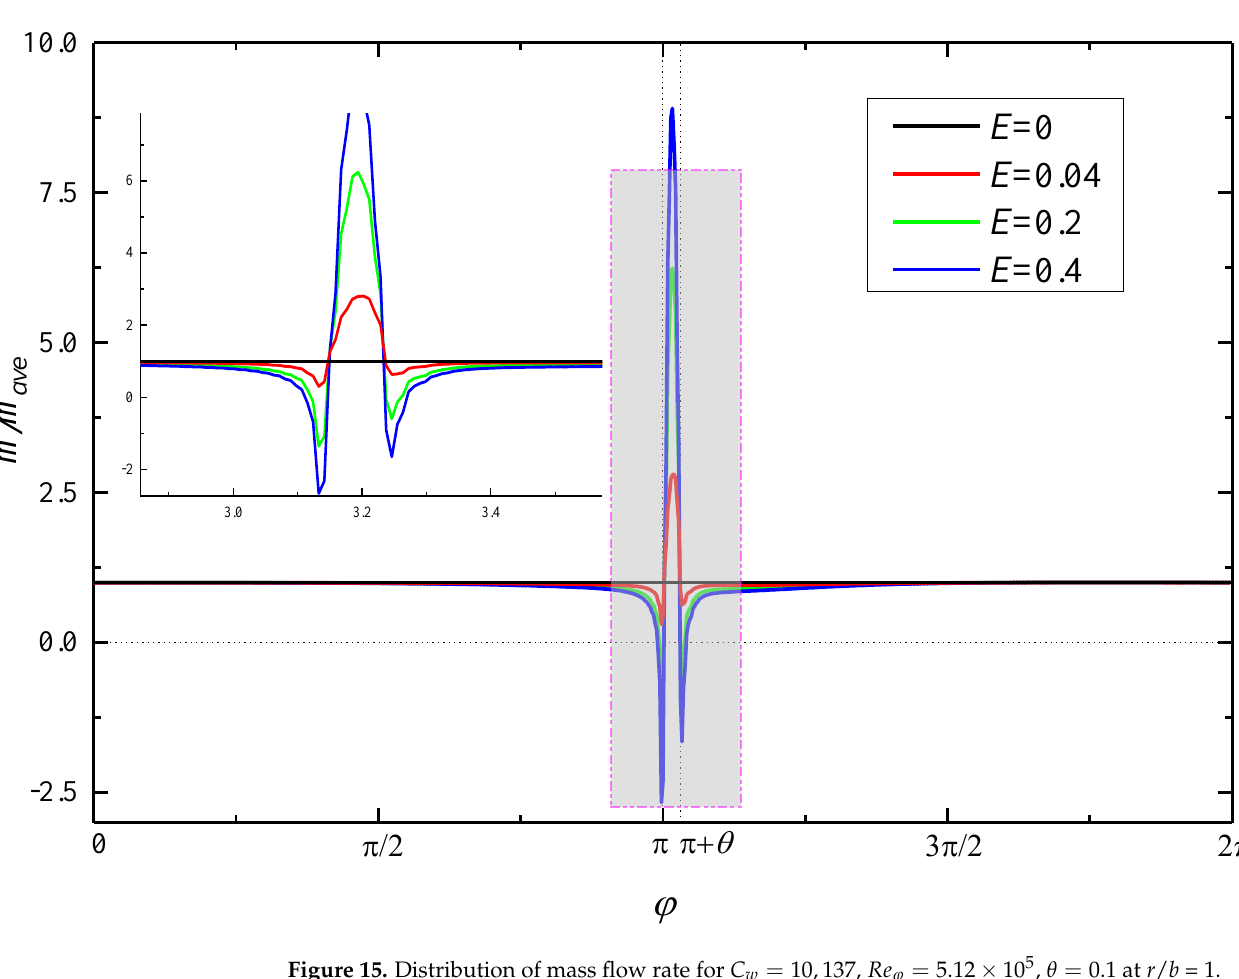
Figure 15. Distribution of mass flow rate for 𝐶